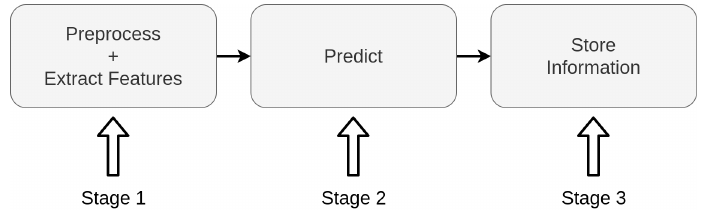
Figure 17. Pipeline for the hardware validation